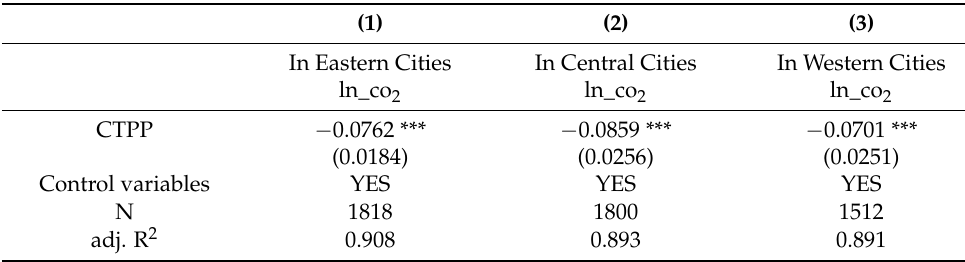
Table 10. Regression results by